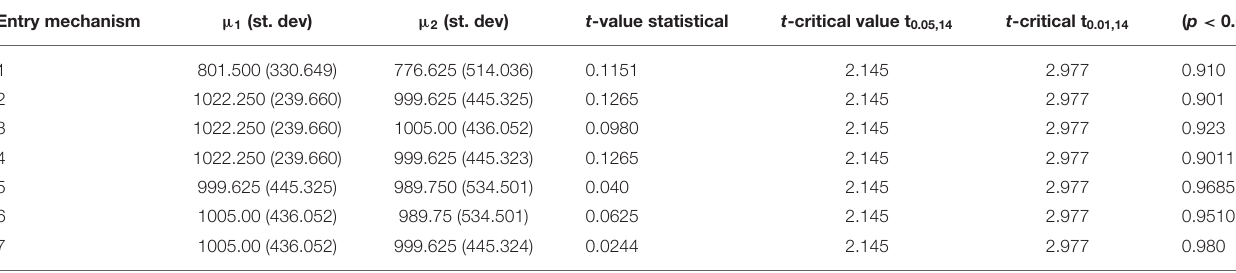
TABLE 2 | Results of two-tailed t -test for the entry maneuvers with similar entry mechanism. Entry